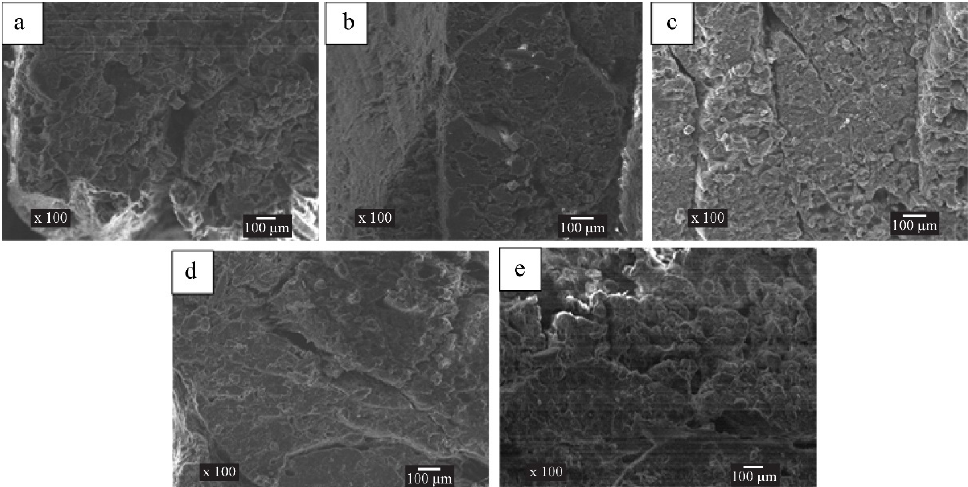
Figure 5. Scanning electron microscopy images showing chicken drumstick muscles that received different cooling treatments. ( a ) Vacuum cooling; ( b – e ) immersion vacuum cooling in salt ion concentrations of 0%, 3%, 5%, and 7%, respectively. Scale bars: 100 μ m.